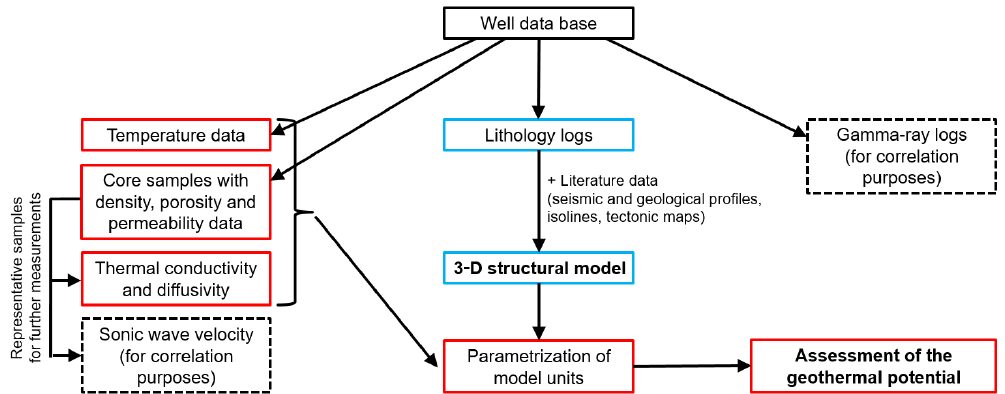
Figure 2. Flowchart illustrating the input data and steps for the construction of the 3-D structural model (highlighted in blue) and the assessment of the geothermal potential (highlighted in red). Steps in dashed line boxes are only shown for completeness but are not further discussed in this